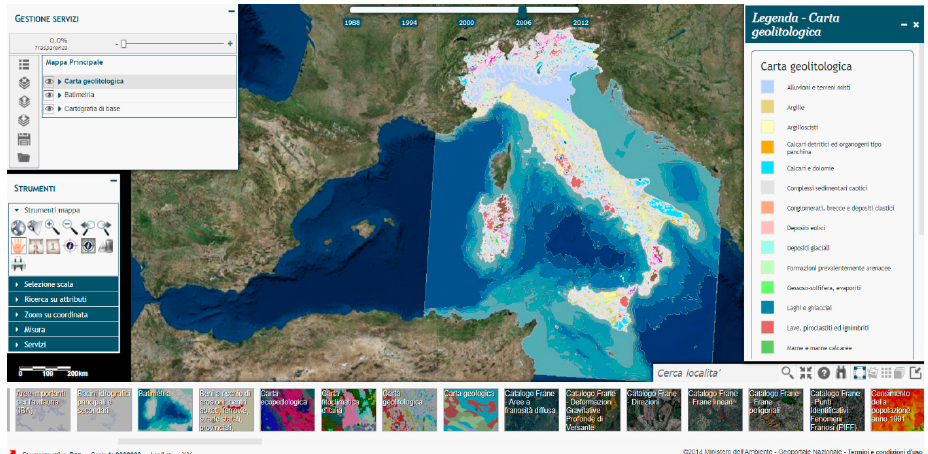
Figure 2. Repertorio Nazionale dei Dati Territoriali, the portal of the National Catalog for Spatial Data (RNDT). Source: own study based on data from http: // www.pcn.minambiente.it / viewer /